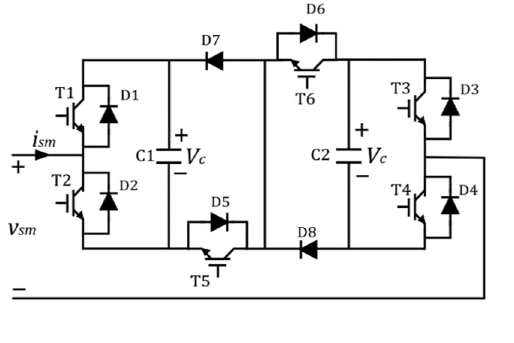
Figure 14. TLCCSM.